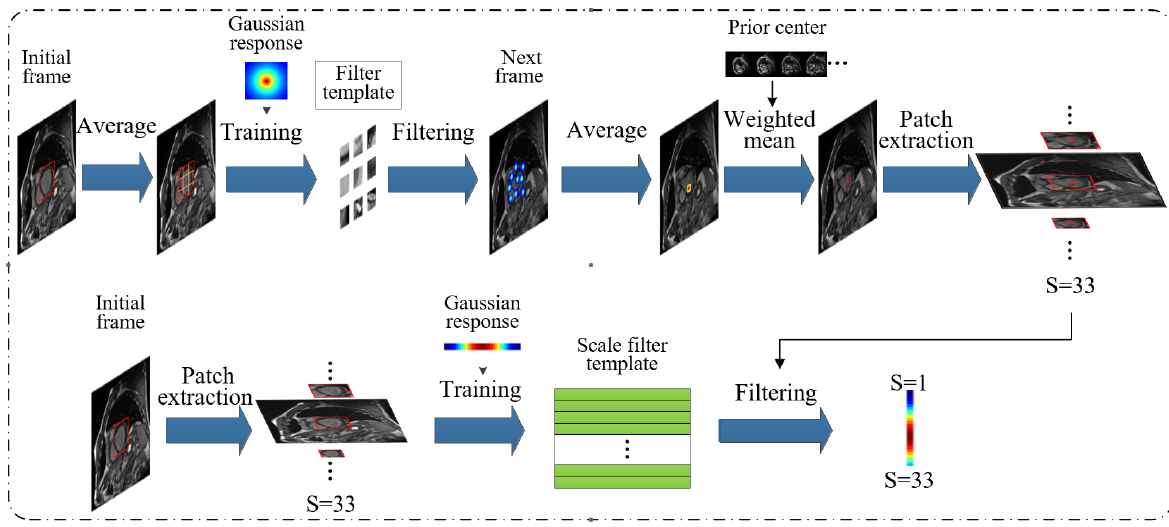
Figure 6. Fast-scale adaptive anchors generation module, where significant anchors are quickly generated through correlation filtering based on the current frame detection